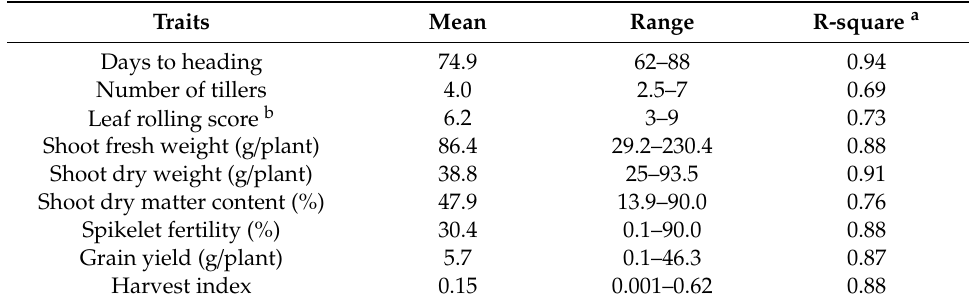
Table 1. Mean, range and r-square value for various agronomic traits, yield, and yield-related traits in rice genotypes under drought stress.